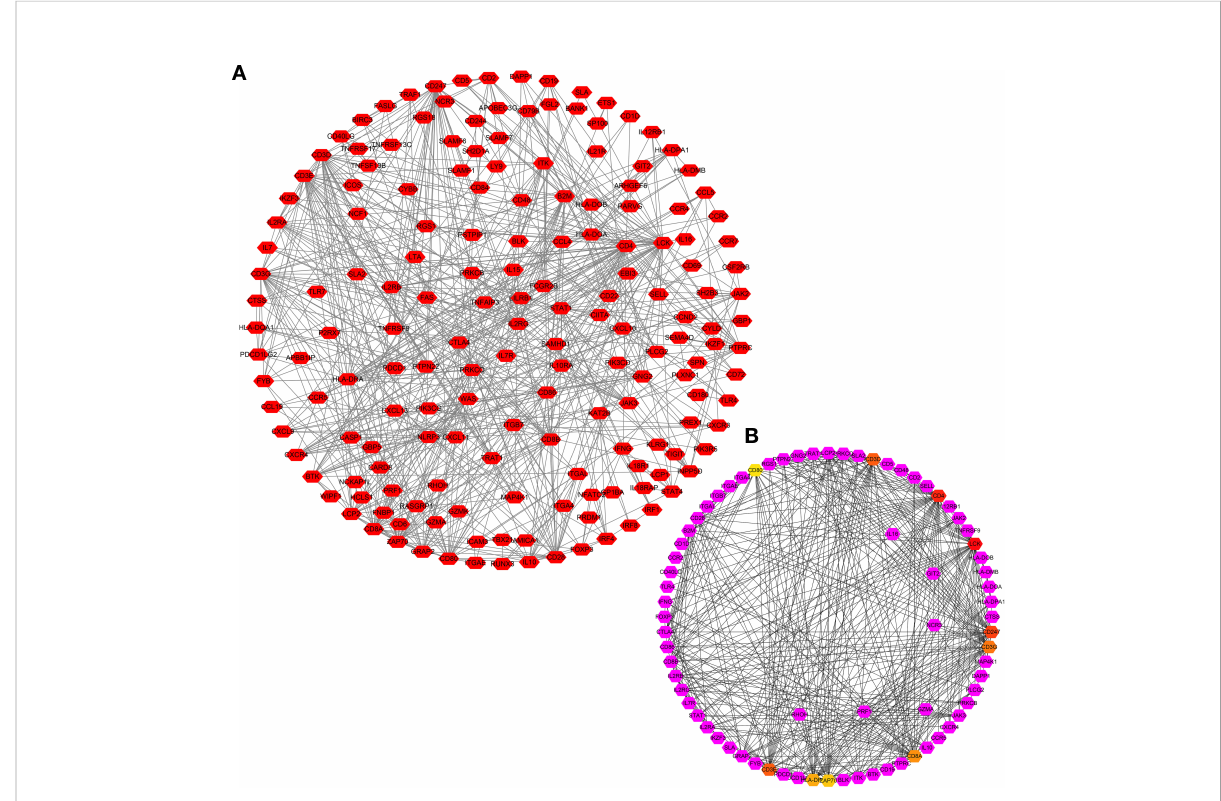
FIGURE 5 PPI network of TRAT1 co-expressed genes. (A) PPI network; (B) Hub genes in network. PPI, protein-protein